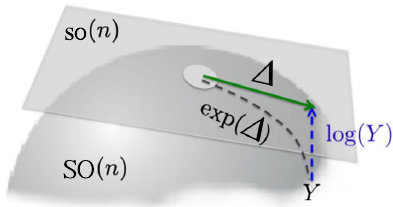
Fig. 1 Example of a special orthogonal group: mappings between a Lie group and a Lie algebra using the exponential and logarithmic maps.